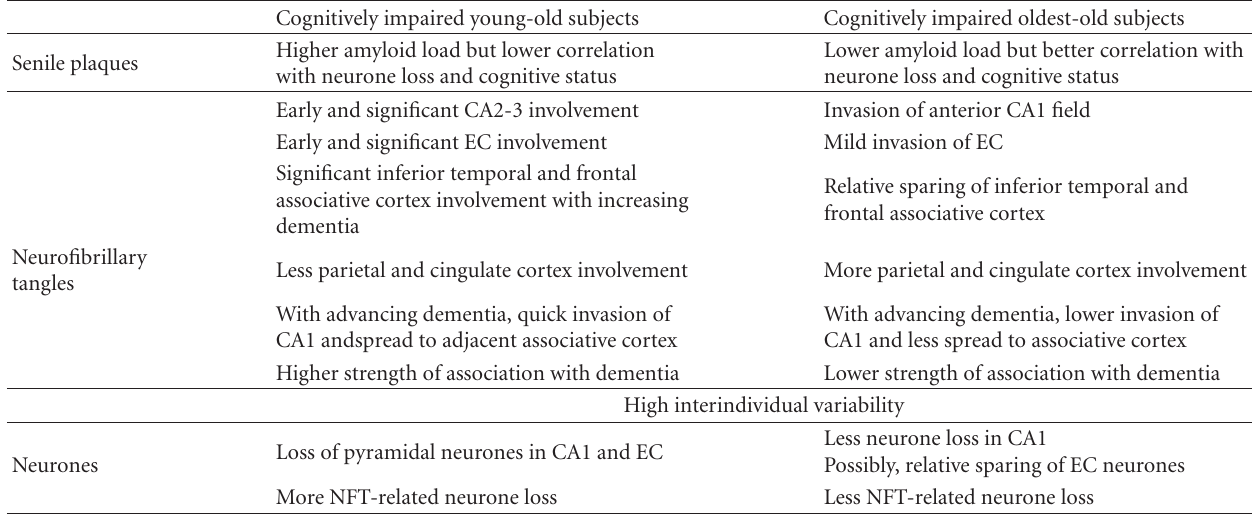
Table 1: Alzheimer’s disease pathology in the cognitively impaired young-old versus oldest-old. Cognitively impaired young-old